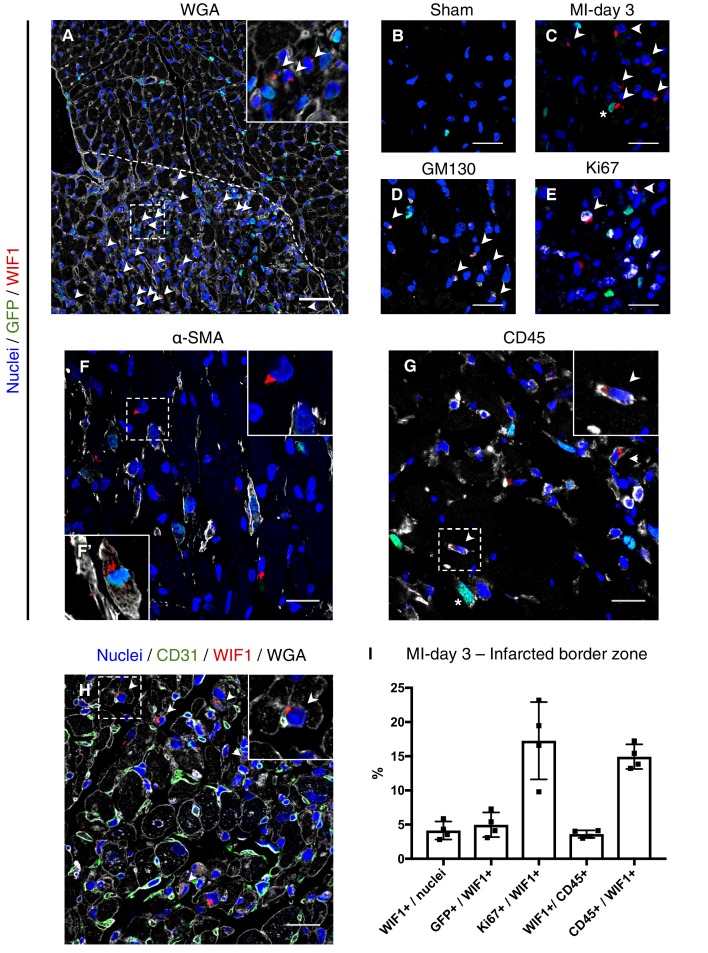
WIF1 localization and co-expression in injured and uninjured hearts of Pdgfra-GFP+ mice.(A) Representative image of WIF1 (red), GFP (green) and Wheat Germ Agglutinin (WGA, grey) co-immunostaining showing the border zone at MI-day 3. Arrowheads show WIF1+ cells. Scale bar - 50 μm. (B–C) Representative images of WIF1 (red) and GFP (green) co-immunostainings showing left ventricle (sham, (B) or infarcted border zone at MI-day 3 (C). Arrowheads show WIF1+ cells, Asterix shows WIF1+GFP+ cells. Scale bars - 20 μm. (D–G) Representative images of co-immunostainings for WIF1 (red), GFP (green) and markers (gray) for golgi (GM130, D, Arrowheads show WIF1+GM130+ cells), proliferation (Ki67, E, Arrowheads show WIF1+Ki67+ cells), smooth muscle cells and myofibroblasts (α-SMA, F, (F’) showing an example of a WIF1+GFP+α-SMA+ cell from another section), and leukocytes (CD45, G, Arrowheads show WIF1+CD45+ cells, Asterix shows GFP+CD45+ cells). Scale bar - 20 μm. (H) Representative image of co-immunostaining for WIF1 (green), WGA (gray) and endothelial cell marker CD31 (green). Arrowheads show WIF1+ cells in close proximity/contact with CD31+ cells. Scale bar - 20 μm. (I) Quantification of marker-positive cells in the infarcted border zone of MI-day 3 hearts. n = 4.10.7554/eLife.43882.029Figure 6—source data 1.Source data for quantification of marker-positive cells summarized in Figure 6I.